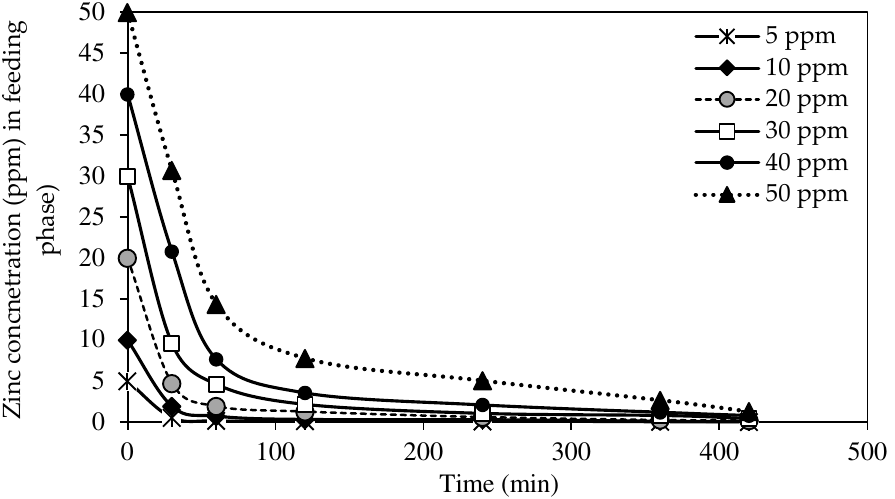
Figure 12. The effects of initial Zn 2+ concentration on metal ion transport of the W3 membrane.